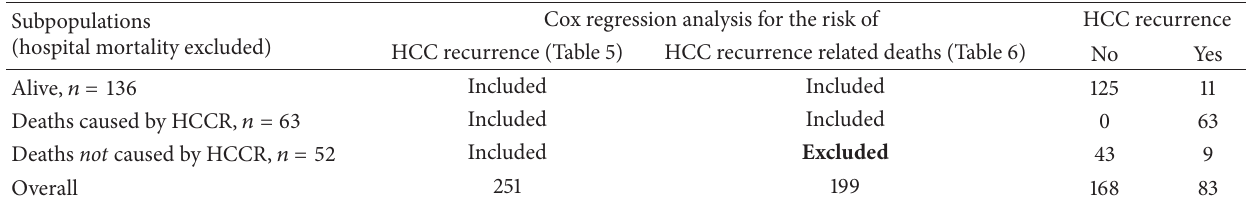
Table 1: In- and excluded subpopulations for the analysis of HCC recurrence and HCC recurrence related deaths.